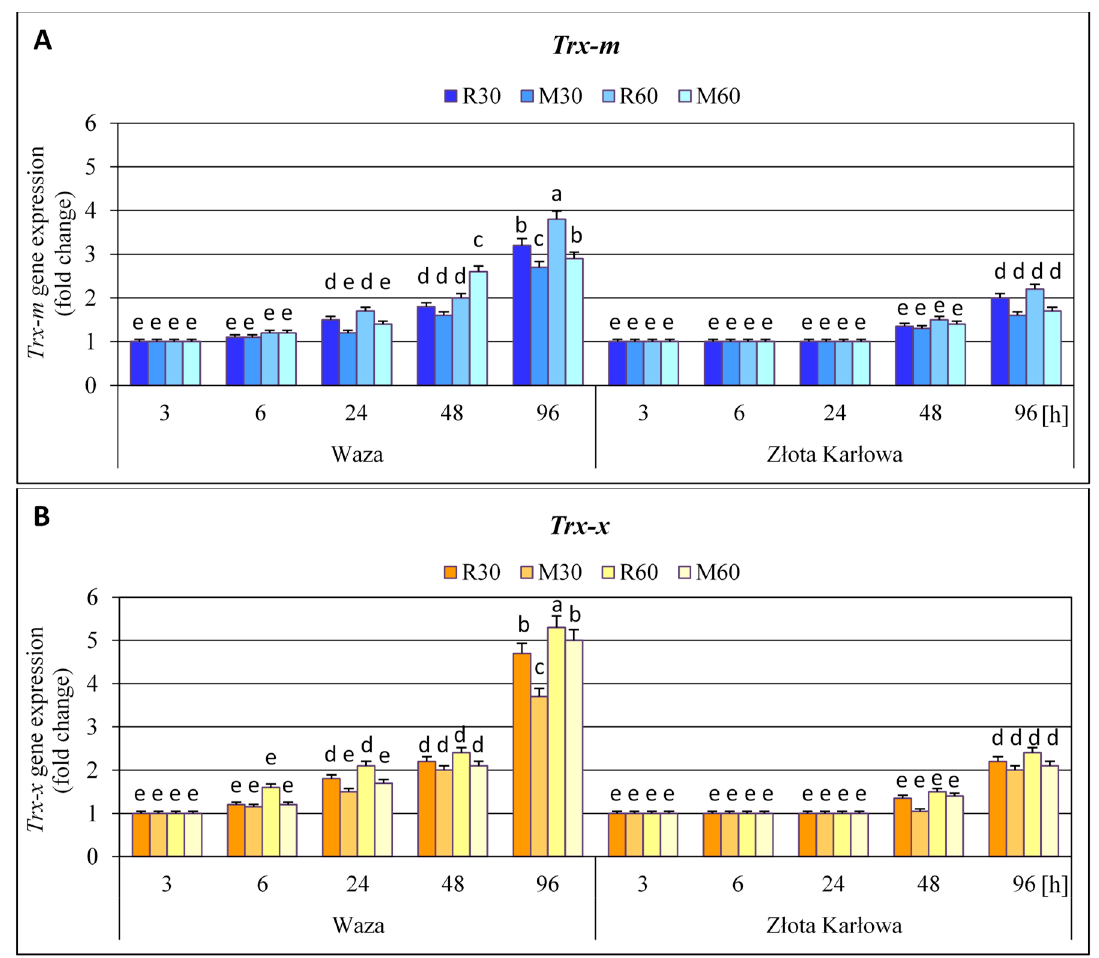
Figure 1. Transcriptional responses of Trx-m ( A ) and Trx-x ( B ) genes in the aphid-treated maize